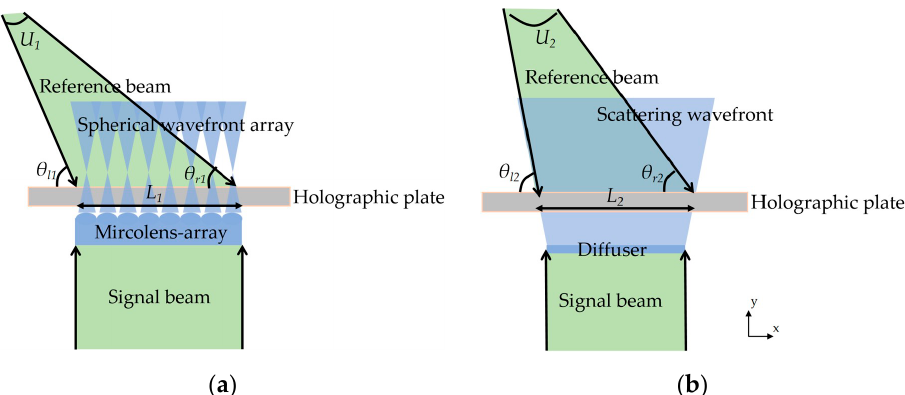
Figure 3. Two-step recording process of MHOE: ( a ) First recording with the MLA; ( b ) second recording with the diffuser.